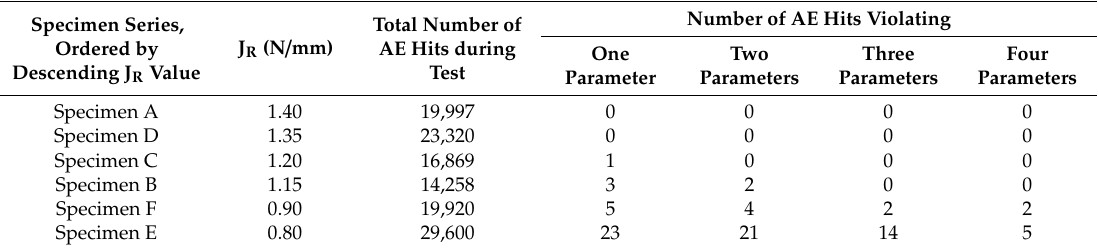
Table 1. Table of results sWhowing dual cantilever beam (DCB) specimens J R value and acoustic emission (AE) characteristic